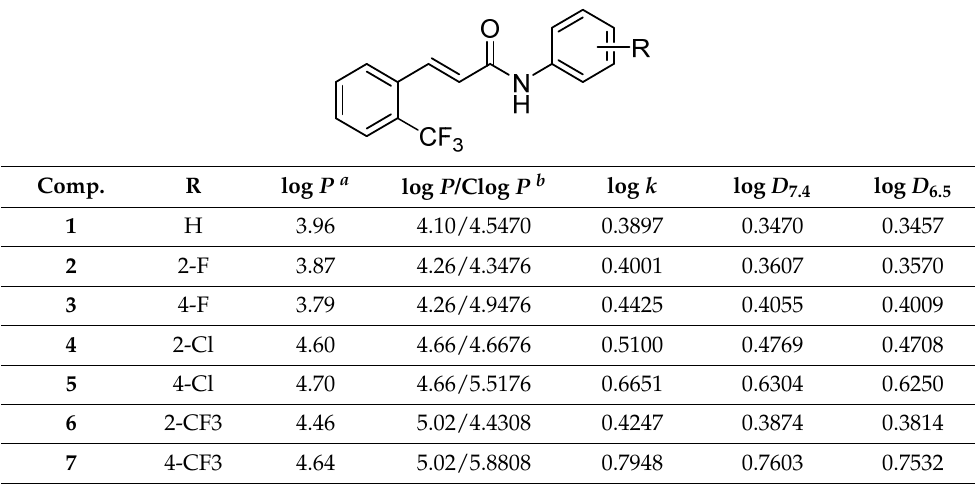
Table 1. Structure of ring-substituted (2 E )- N -aryl-3-[2-(trifluoromethyl)phenyl]prop-2-enamides 1 – 7 , calculated lipophilicities (log P /Clog P ), and experimentally determined log k , log D 7.4 , and log D 6.5 values of investigated compounds.